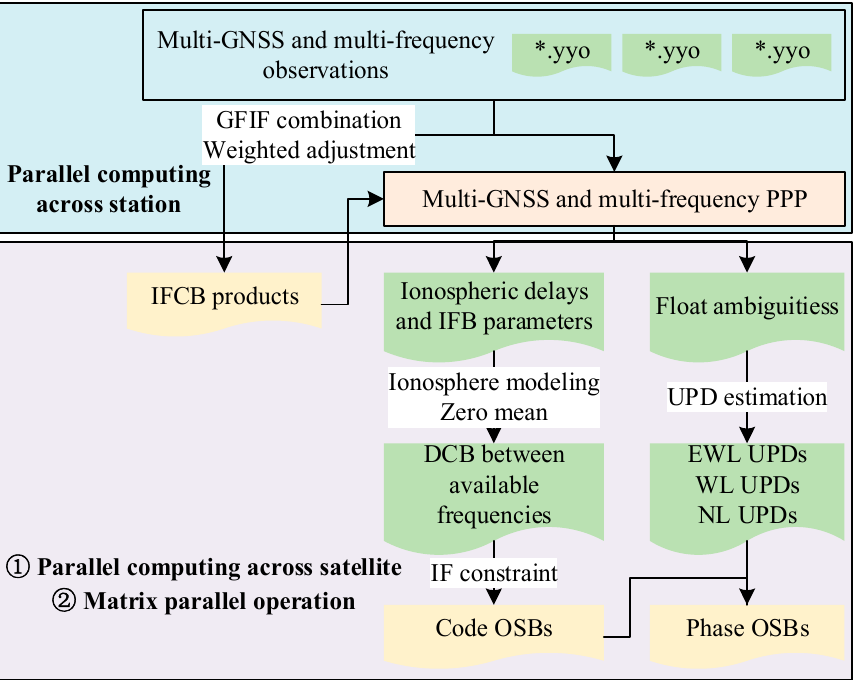
Figure 2. The parallel estimation flowchart of IFCBs, code, and phase OSBs under a multicore platform. Three parallel computing methods involving inter-station, inter-satellite, and matrix operation are employed. The symbol * represents the station name.